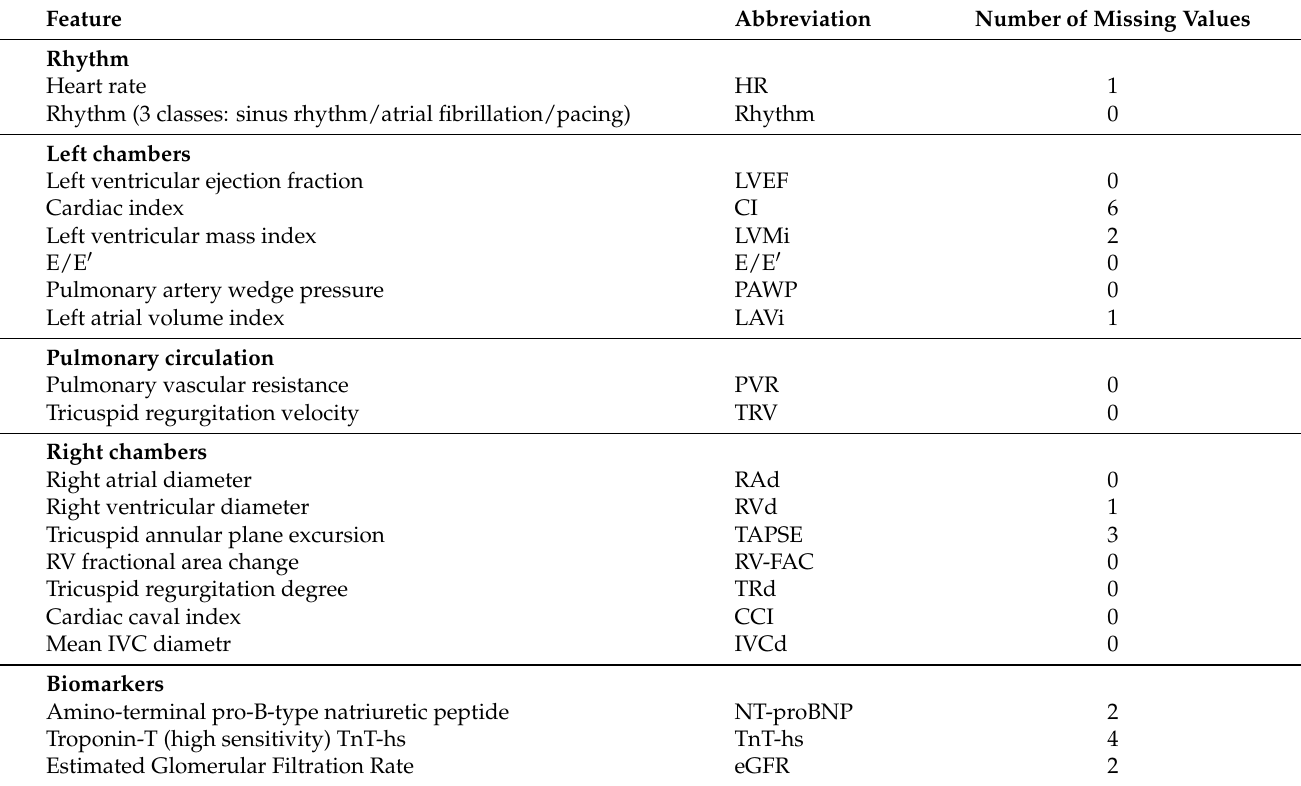
Table 1. Features included in this study, with indication of the number of missing values (170 pa- tients